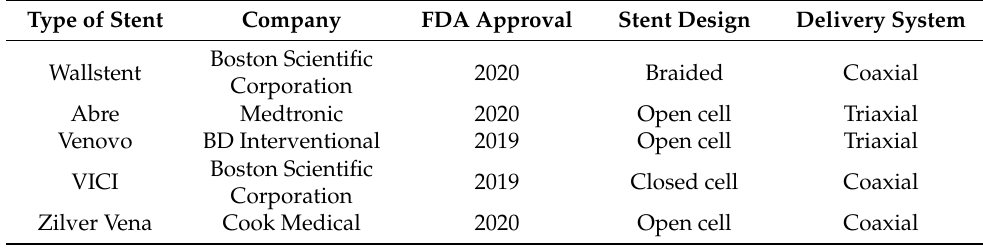
Table 3. Patencies of various types of venous stents. Type of Stent Trial Patients (N) Patency No formal clinical trial; plethora of data Wallstent